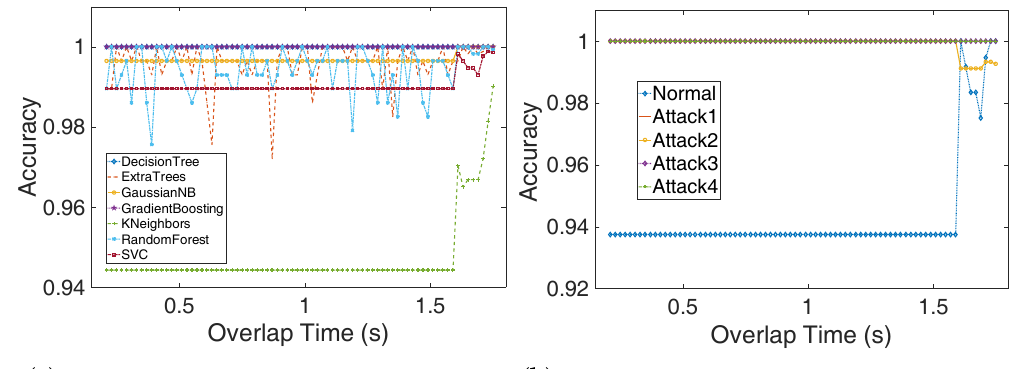
Figure 12. The influence of overlap time t o . The sliding window size t s is fixed to 1.8 s. ( a ) The detection accuracy increases as the overlap time increases, this is mainly because when the overlap time is close to window size, the relationship between adjacent samples becomes closer, and each type of sample can better reflect the corresponding running state of the DTU; ( b ) The detection accuracy also increases as the overlap time increases when using the multiclass